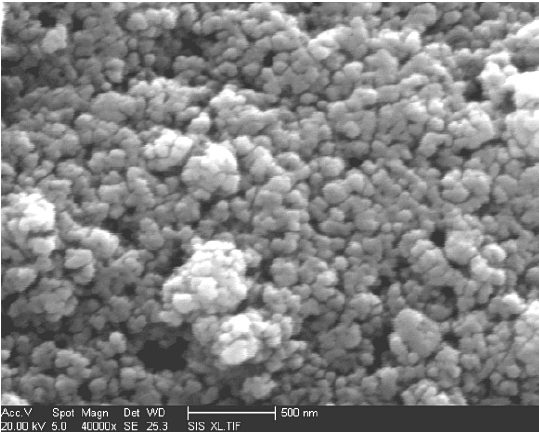
Figure 5. SEM images of the Nb/In 2 O 3 sensing film.